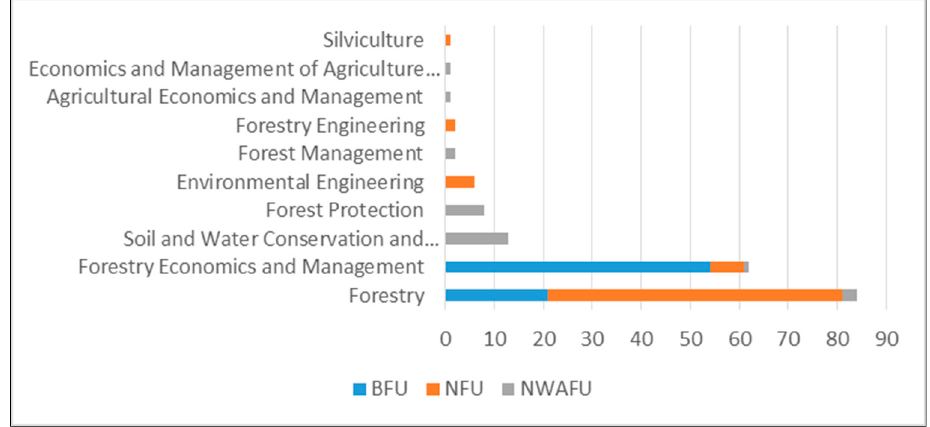
Figure 3. Major choices of APFNet Scholarship Program students (number of students). Table 2. Responses to questions regarding options and preference for more flexibility in choices of subjects in